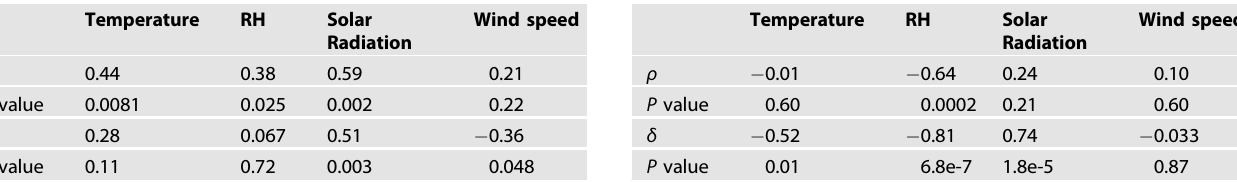
Table 2. Direct and partial Spearman correlation* of Salmonella persister switch rate α with average of 8-h weather factors.